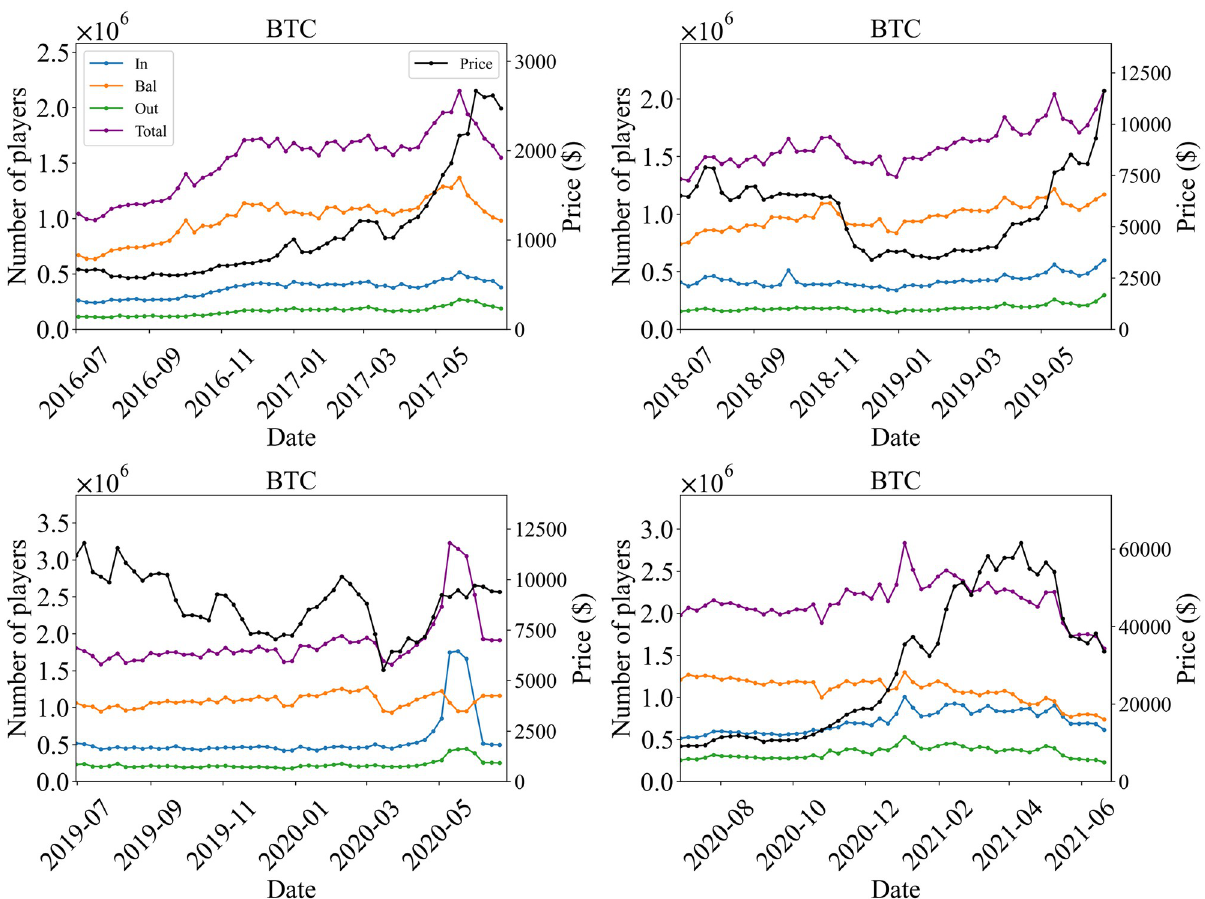
Fig 9. Time series of the number of In-, Bal-, and Out-players (weekly total) of Bitcoin for periods (July 3 2016 Sunday to July 1 2017 Saturday), (July 1 2018 Sunday to June 29 2019 Saturday), (Jun 30 2019 Sunday to June 27 2020 Saturday), and (June 28 2020 Sunday to June 26 2021 Saturday). The black line represents the one-week-average